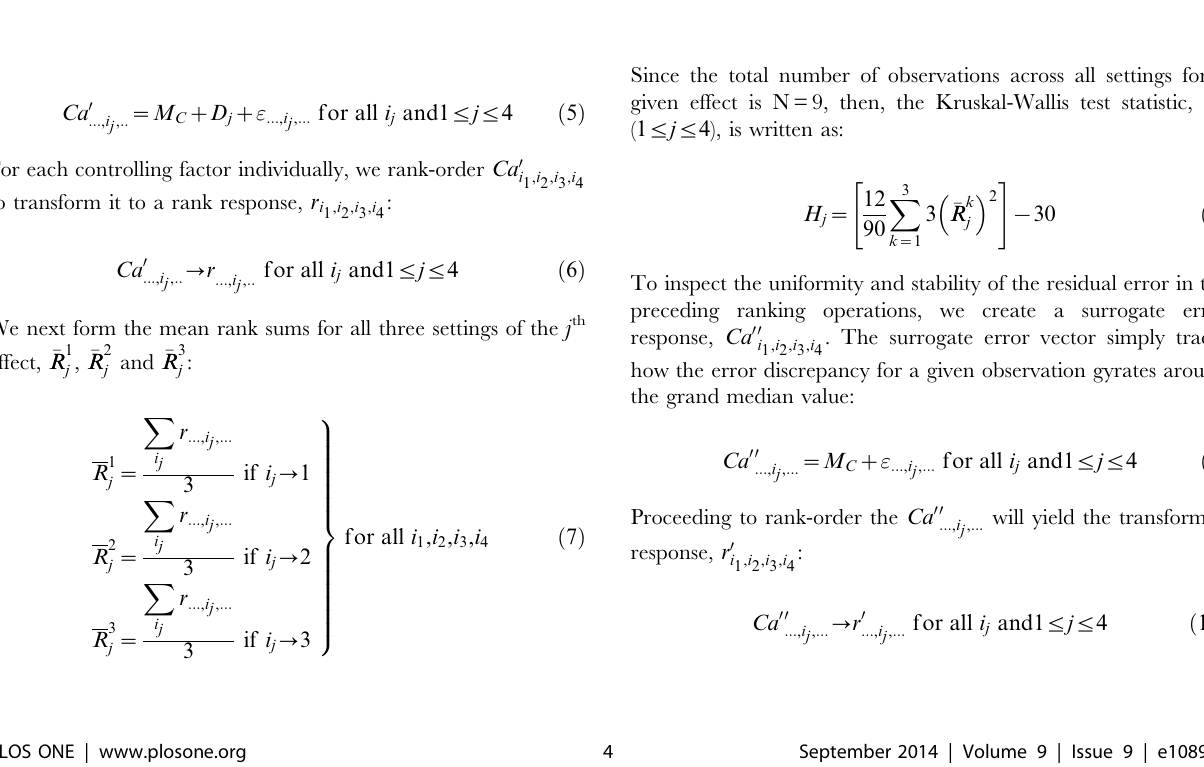
Figure 1. The configuration of a surrogate response by un-stacking and re-assembling an amplicon-count observation generated by the unreplicated-saturated OA scheme.